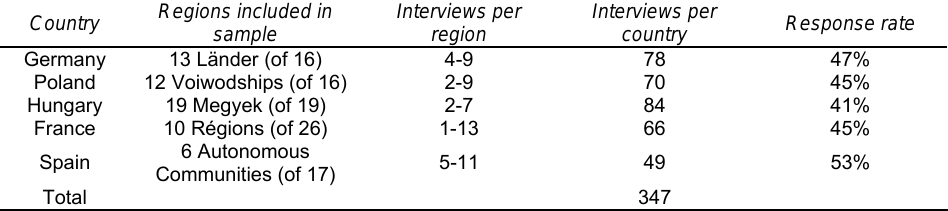
Table 2: Sample structure Regions included in Country sample